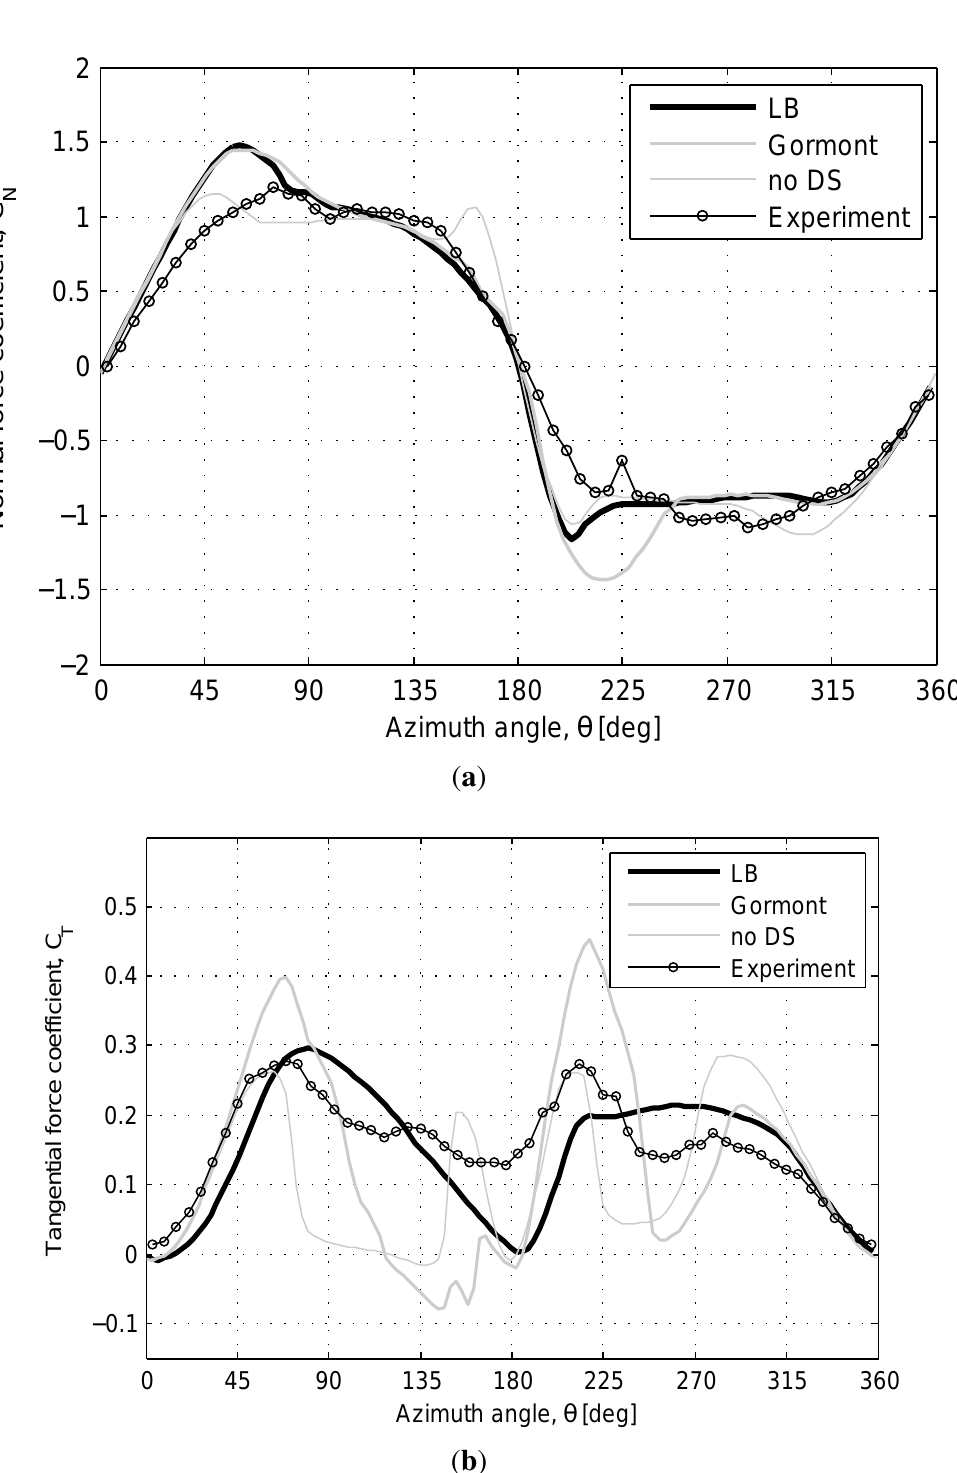
Figure 9. Force response at a TSR of 2.49. ( a ) Normal force; ( b ) tangential